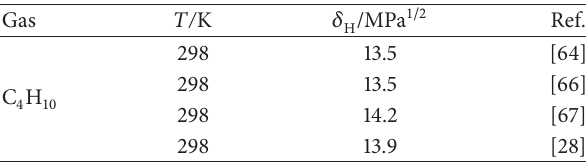
Table 4: Literature values of solubility parameters of gases near ambient temperatures.